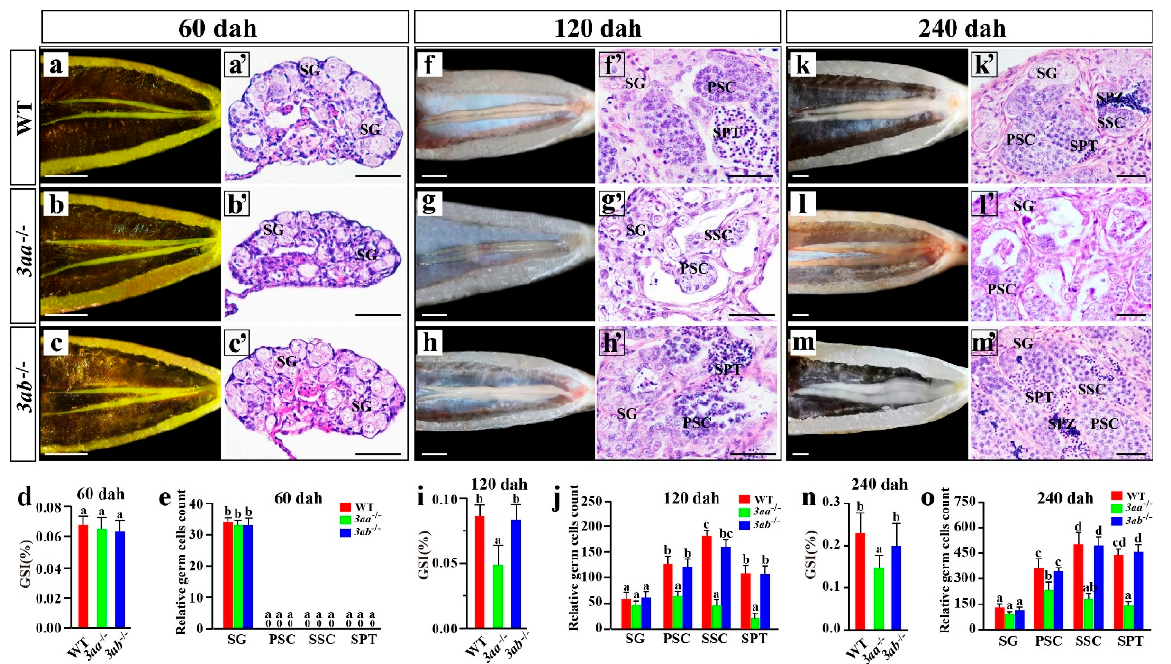
Figure 4. Morphological and histological analyses of WT, dnmt3aa − / − and dnmt3ab − / − testes at 60, 120 and 240 dah. ( a – c , a ’ – c ’ , f – h , f ’ – h ’ , k – m , k ’ – m ’ ) Morphological and histological observation. ( d , i , n ) Gonadosomatic index (GSI) ( n = 10 for each genotype). ( e , j , o ) Statistical analysis of germ cell counting ( n = 5 for each genotype). Germ cells from the median sections of testes were counted for statistical analyses. ( a – c ) Gonads were fixed with Bouin’s solution. Different letters above the error bar indicate statistical differences at p < 0.05 as determined by one-way ANOVA followed by Tukey’s post hoc test. Results are presented as mean ± SD in ( d , e , i , j , n , o ). Scale bar in ( a – c , f – h , k – m ), 1 cm. Scale bar in ( a ’– c ’, f ’– h ’, k ’– m ’), 10 µ m. dah, days after hatching; PSC, primary spermatocytes; SG, spermatogonia; SPT, spermatids; SPZ, spermatozoa; SSC, secondary spermatocytes.